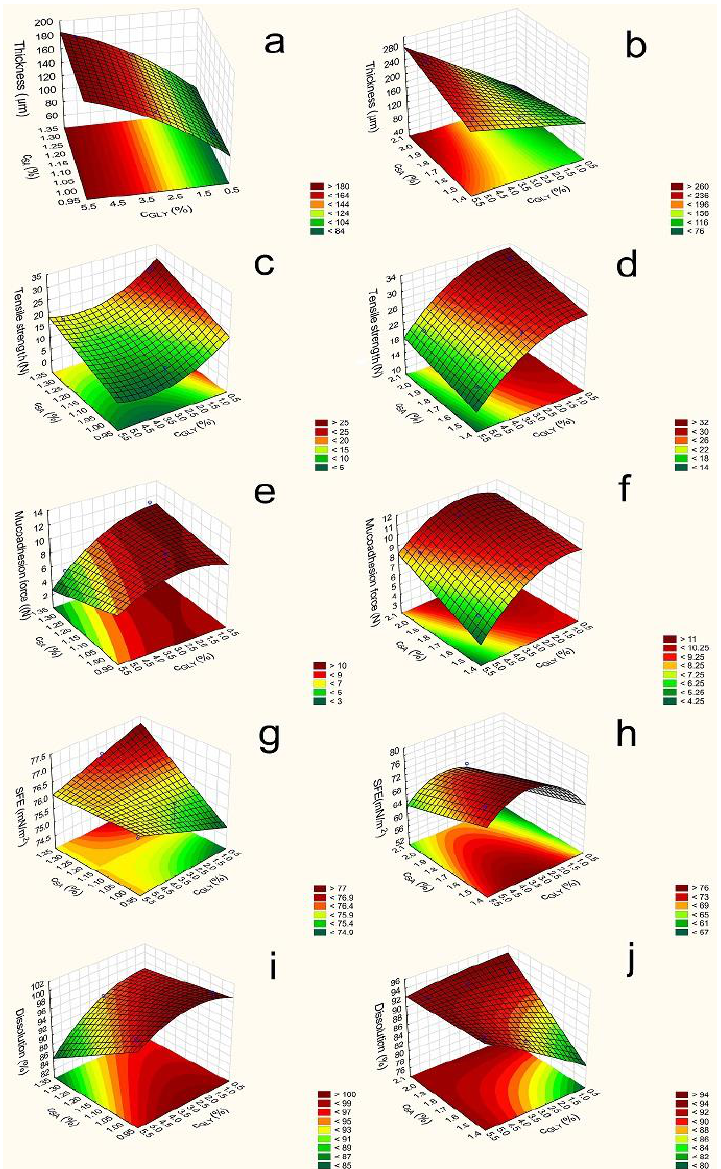
Figure 2. Response surface of polymer films containing CTZ ( left side —2% polymer films; right